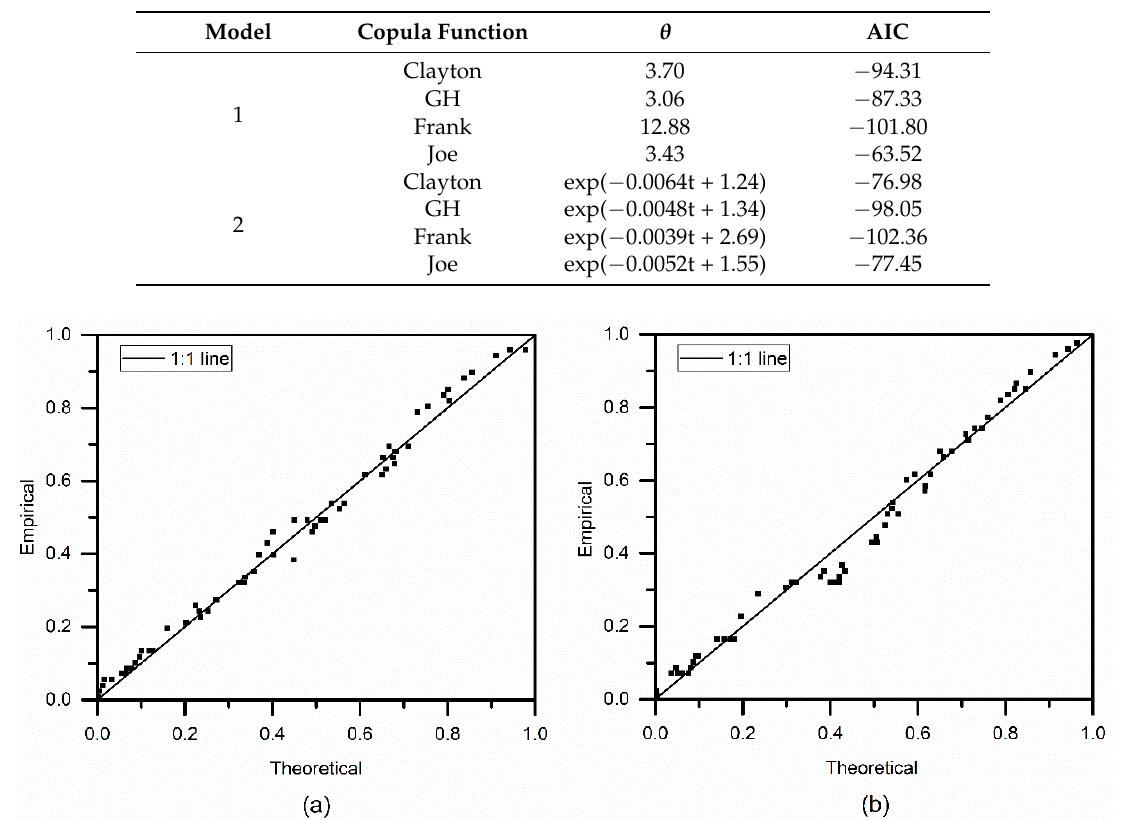
Table 4. The parameters and goodness-of-fit tests for candidate copulas.